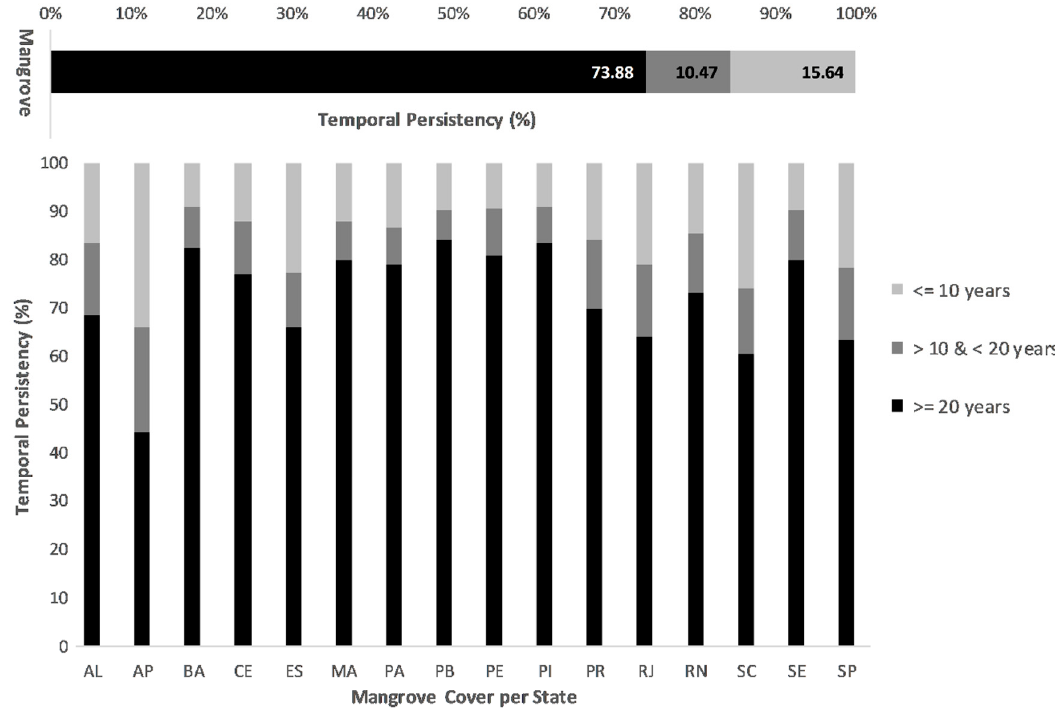
Figure 10. Brazilian mangrove cover persistence at the national and regional scale. The top bar shows the overall mangrove persistence. The bottom graph shows the mangrove persistence per state, abbreviated as in Figure 2. The x -axis represents the state distributions, whereas the y -axis represents the mangrove cover temporal persistence percentages (%). Black represents 20 years or more of stability, dark grey indicates stability between 10 and 20 years and light grey represents stability for less than 10 years.